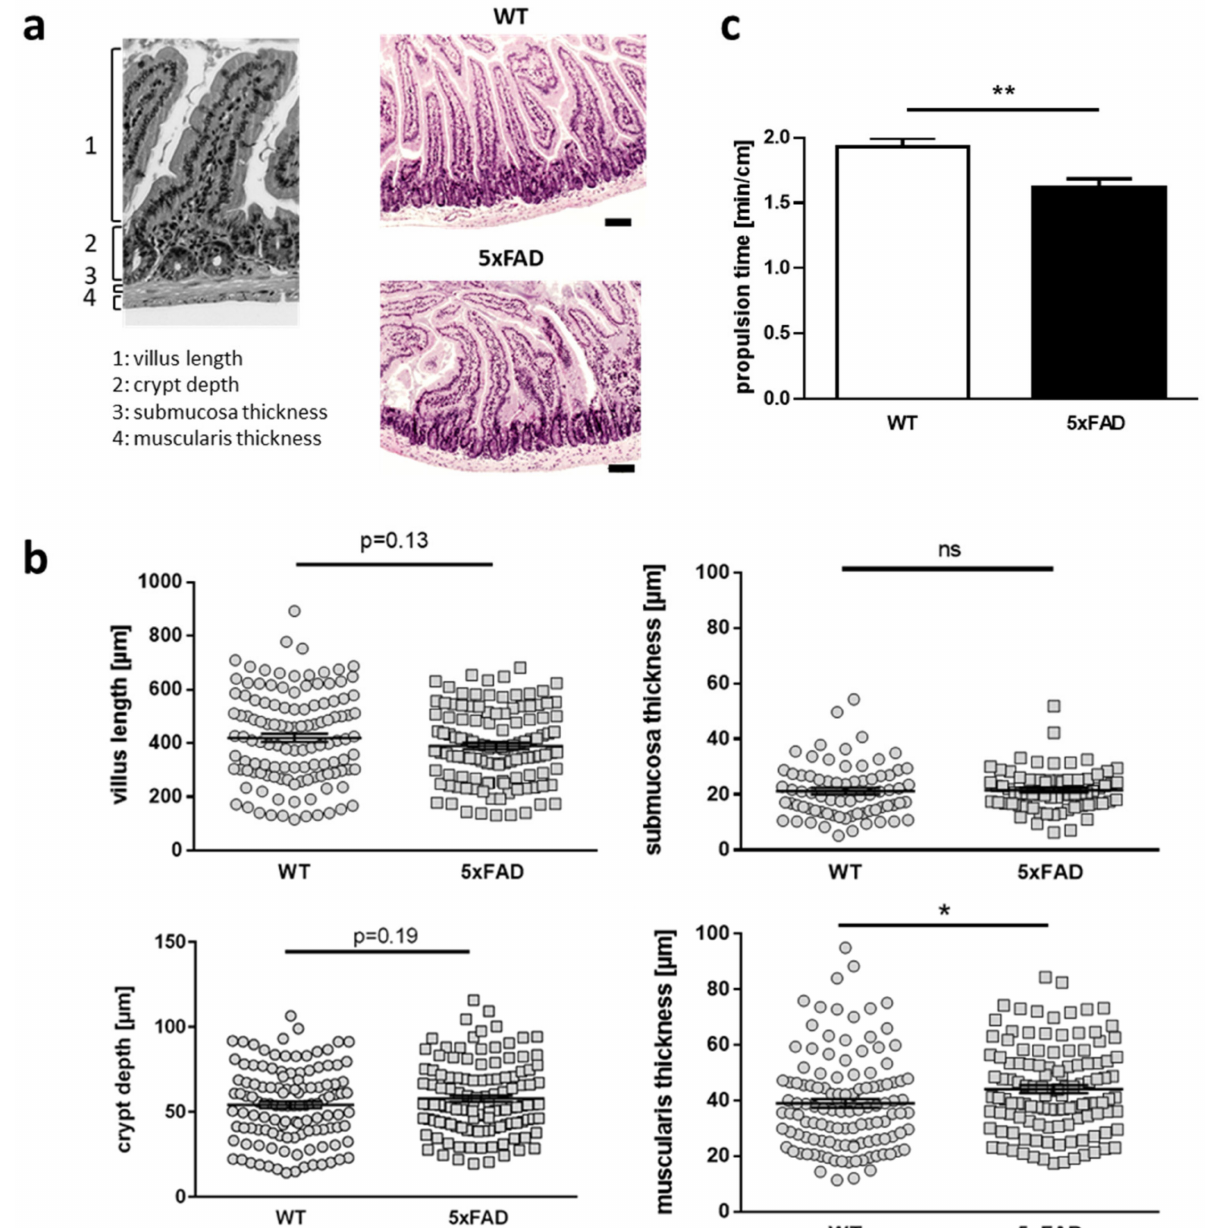
Figure 1. Morphological and functional changes were observed in the gut of 5xFAD model mice. ( a ) Quantitative parameters were assessed within duodenal slices of mice. Gut slices were stained with HE (representative images for wild type and 5xFAD mice are shown) and respective structures were measured ( b ) The four anatomical structures villus length, crypt depth, submucosa and muscularis thickness were analyzed with four measurements of each duodenal structure in three slides per mouse ( n = 10 animals per group, aged 11 weeks, single values are shown) by using a clock-wise orientation in AD model mice and their respective wild type littermates. ( c ) Measurement of gut motility. Distal colonic sections ( n = 6 per group, mean age 25 weeks) were dissected and inserted into an organ bath with carbogen-gas perfused Krebs solution. A fecal pellet was inserted in the oral end and time measured for transport to the anal end. Statistical analysis was performed by using Student’s t -test ( n = 6 per group; * p < 0.05; ** p <